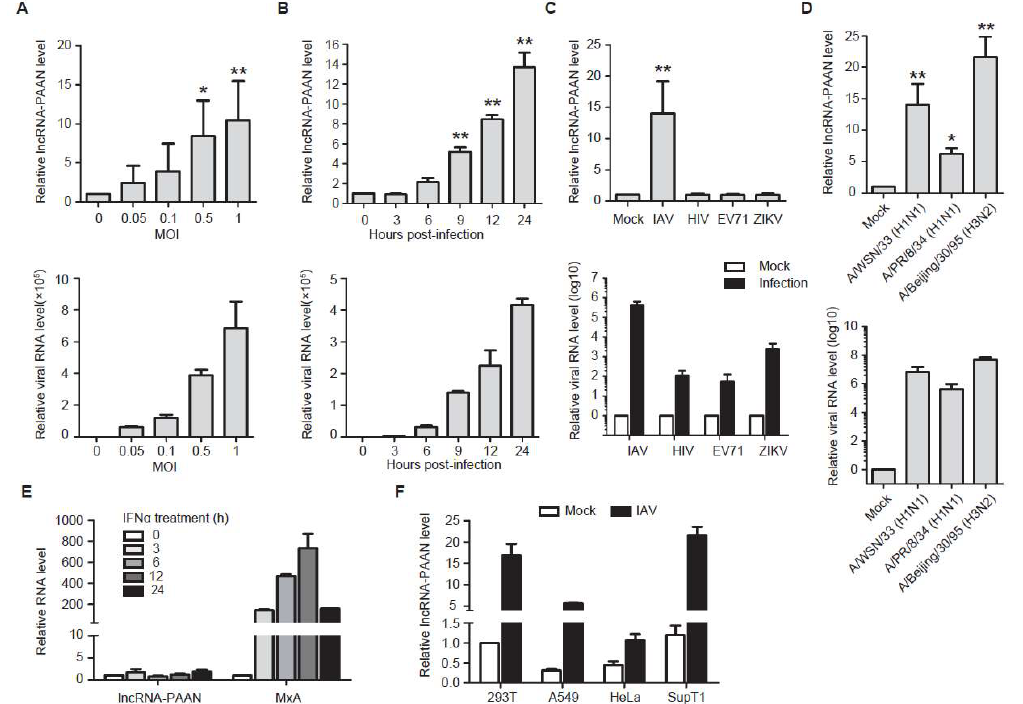
Figure 2. LncRNA-PAAN is induced by IAV infection independent of interferon. ( A ) HEK293T cells were infected with IAV at the indicated MOIs for 24 h. Levels of lncRNA-PAAN (upper panel) and viral RNA (lower panel) were determined by qRT-PCR; ( B ) HEK293T cells were infected with IAV (MOI = 1) for indicated time intervals. Levels of lncRNA-PAAN (upper panel) and viral RNA (lower panel) were determined by qRT-PCR; ( C ) HEK293T cells were infected with IAV, HIV-1, EV71 and ZIKV (MOI = 1) for 24 h. Levels of lncRNA-PAAN (upper panel) and viral RNA (lower panel) were determined by qRT-PCR; ( D ) HEK293T cells were infected with A/WSN/33(H1N1), A/PR/8/34(H1N1) and A/Beijing/30/95(H3N2) (MOI = 1) for 24 h. Levels of lncRNA-PAAN (upper panel) and viral RNA (lower panel) were determined by qRT-PCR; ( E ) Levels of lncRNA-PAAN and MxA mRNA in A549 cells that were treated with IFN-α (1000 IU/mL) for the indicated time intervals; ( F ) Levels of lncRNA-PAAN in different human cell lines after IAV infection (MOI = 1) for 24 h. Levels of lncRNA-PAAN were quantified by qRT-PCR; In ( A – F ) data, the level of GAPDH mRNA was also determined and used as the internal control to normalize the level of lncRNA-PAAN. The value of the control group was arbitrarily set as 1. IAV means the WSN strain unless otherwise specified. *: p ≤ 0.05; **: p ≤ 0.01.